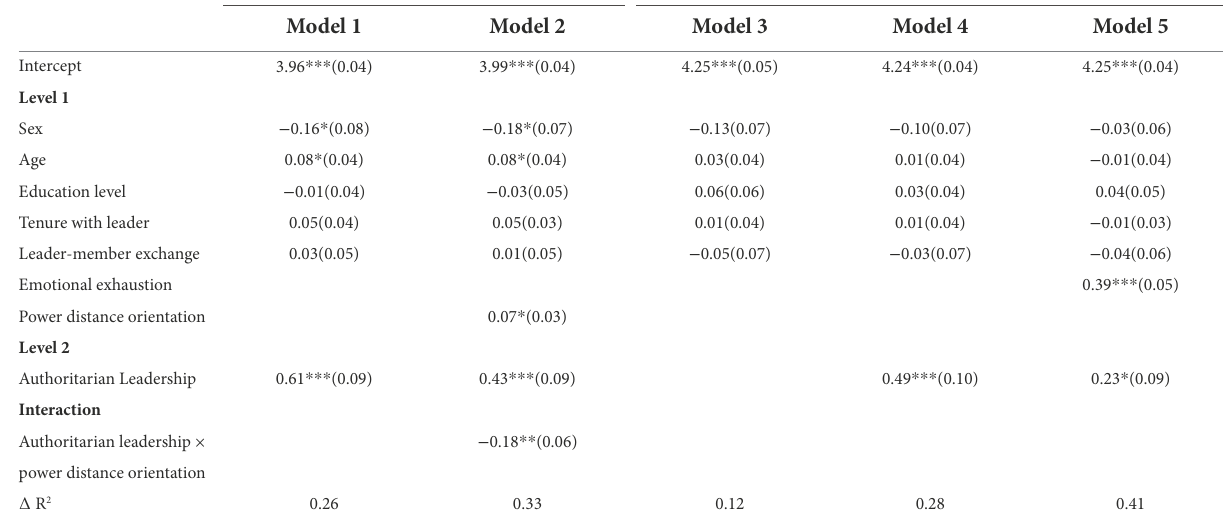
TABLE 3 Results of hierarchical linear